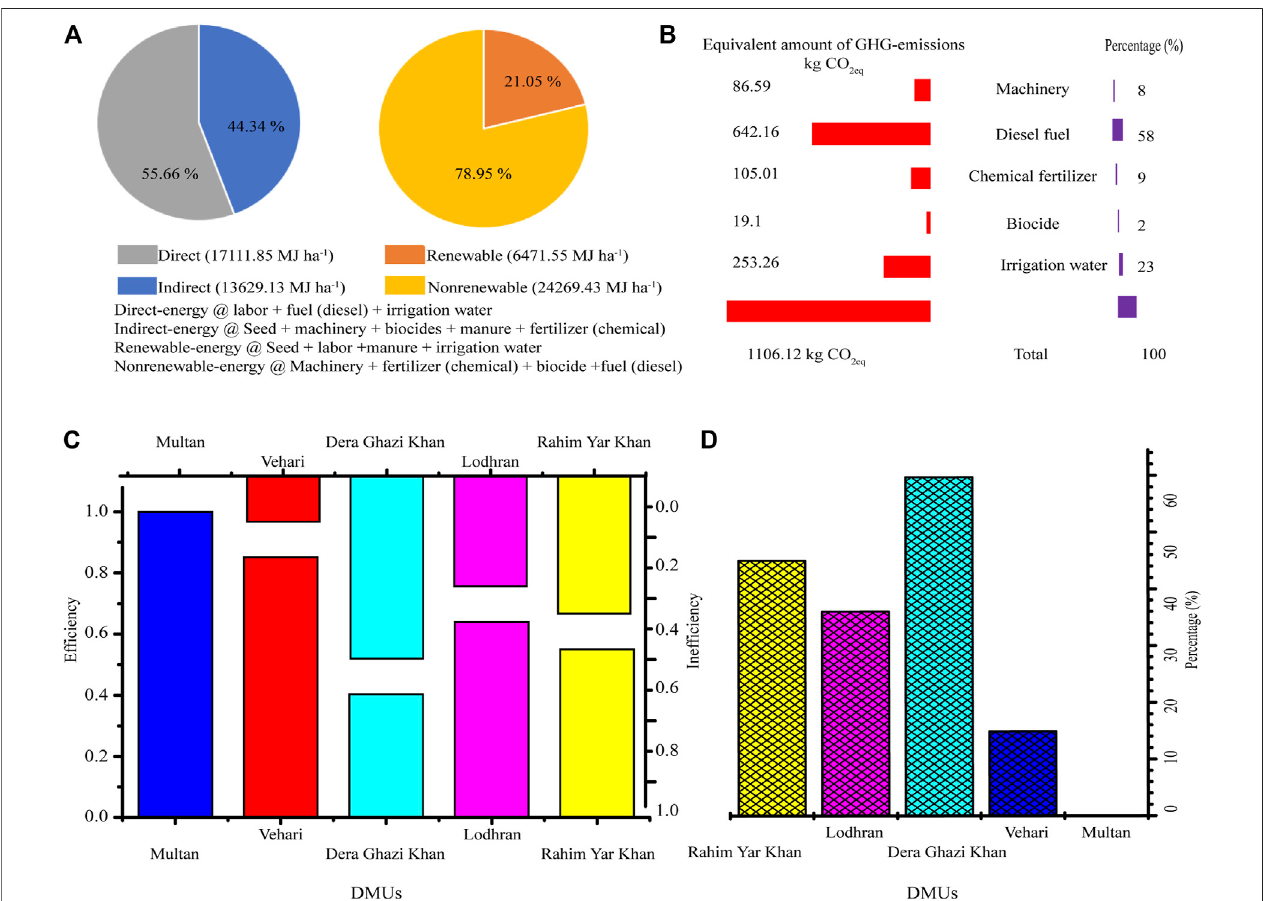
FIGURE2|(A) Shareofdirect,indirect,renewable,andnonrenewableenergies. (B) TheequivalentamountofGHGemissions. (C) Ef fi ciencyandinef fi ciencyscore for each district at DMU1, Vehari; DMU2, Dera Ghazi Khan; DMU3, Lodhran; DMU4, Rahim Yar khan; and DMU5, Multan. (D) Percentage of plausible potential of resource savings in each